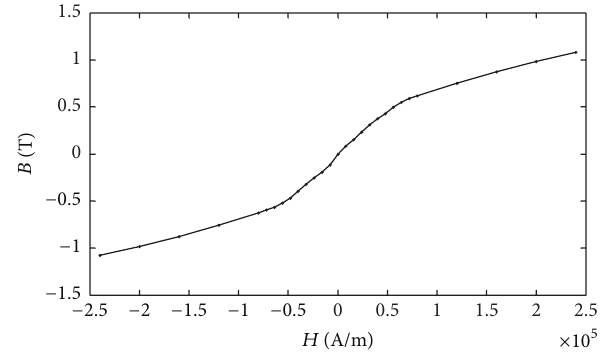
Figure 3: Practical test curves of GMM magnetization.